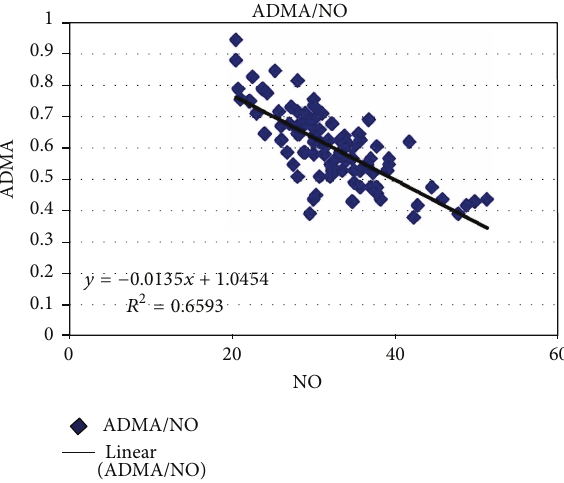
Figure 1: Correlation between ADMA and NO in diseased group. NO cut-off level was 30 𝜇 mol/L. All study groups indicate presence of disease. Our data supports NO which is also one of the independent risk factors and significantly ( 𝜒 2 : 40.65, 𝑃 < 0.001 ) associated with pathogenesis of CAD. The cut- off level for ADMA was 0.60 𝜇 mol/L ( 𝜒 2 : 36.46, 𝑃 < 0.001 ), which is another independent risk factor for